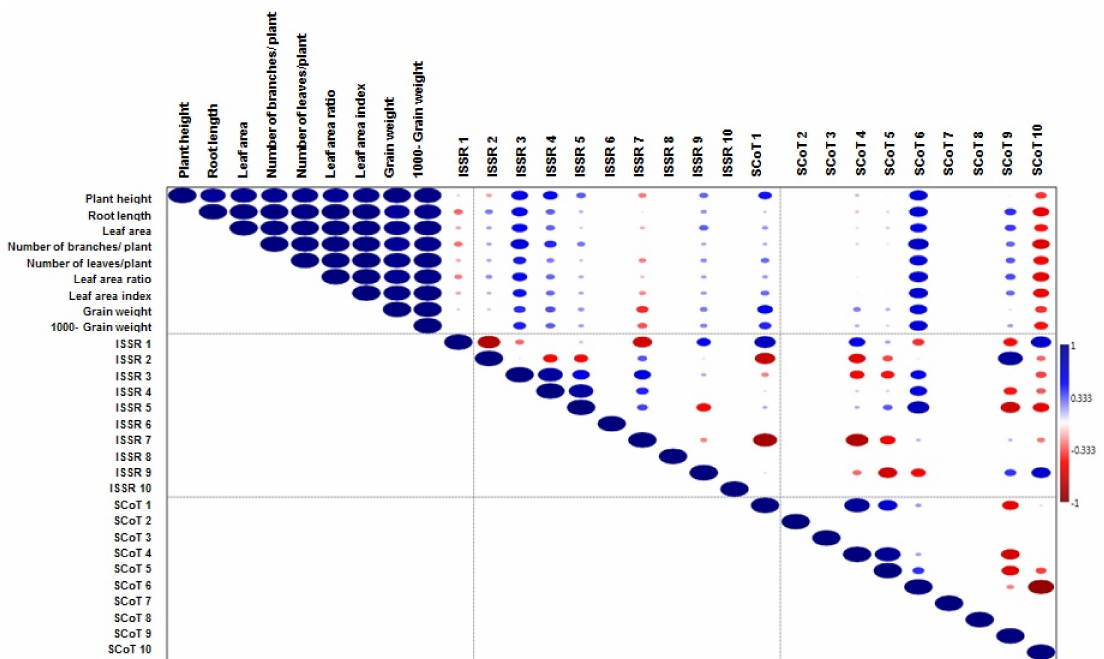
Figure 5. Pearson Correlation among some (morpho-physiological traits & molecular attributes). The blue color indicates a positive correlation, and the red color indicates a negative correlation. The size of the circle, proportional to the correlation coefficient and intensity of color, represented the magnitude of the